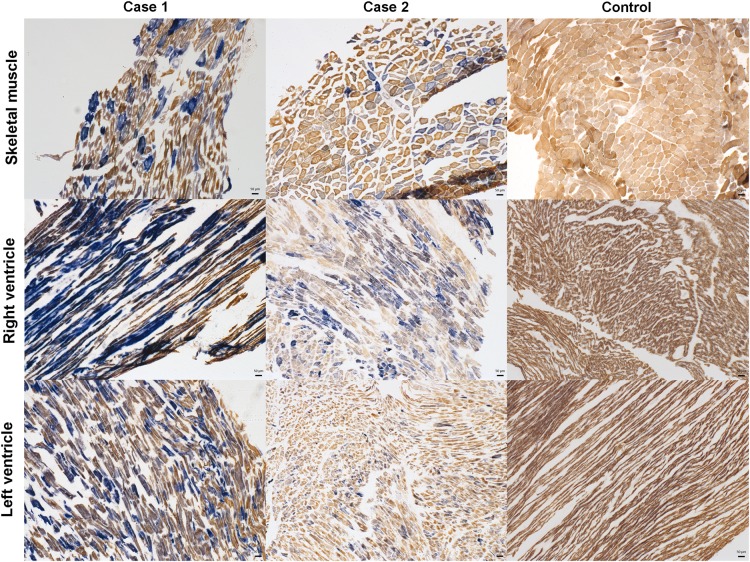
Evidence of mitochondrial dysfunction in skeletal and cardiac muscles by cytochrome c oxidase/succinate dehydrogenase histochemistry. To measure cytochrome c oxidase/succinate dehydrogenase enzyme activity, sequential cytochrome c oxidase/succinate dehydrogenase histochemistry was performed on post-mortem skeletal (quadriceps) and cardiac (right and left ventricle) muscle sections from patients and a control. Cells that are identified by a brown reaction product have functional cytochrome c oxidase and succinate dehydrogenase activity; those that are blue have lost cytochrome c oxidase activity but retain succinate dehydrogenase activity. This assay reveals a mosaic pattern of variable cytochrome c oxidase-deficiency (blue cells) within all patients' tissues (Case 1 and 2), while control tissues (Control) reveal functional cytochrome c oxidase and succinate dehydrogenase activities (brown cells). Scale bar = 50 μm.